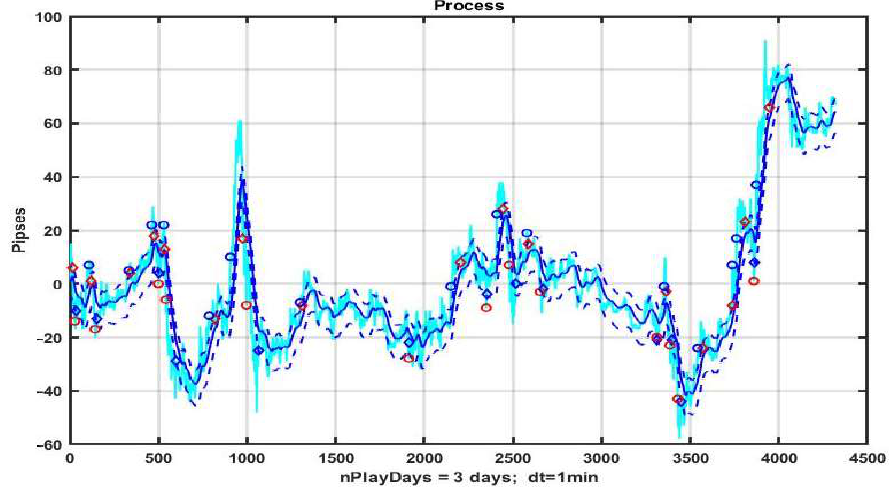
Figure 15. Example implementation of CSB with five optimized parameters.